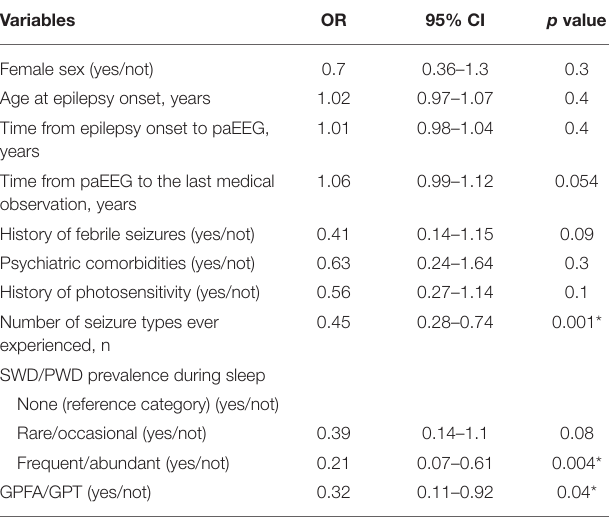
TABLE 2 | Electroclinical characteristics of patients according to the presence or absence of GPFA/GPT during paEEG.